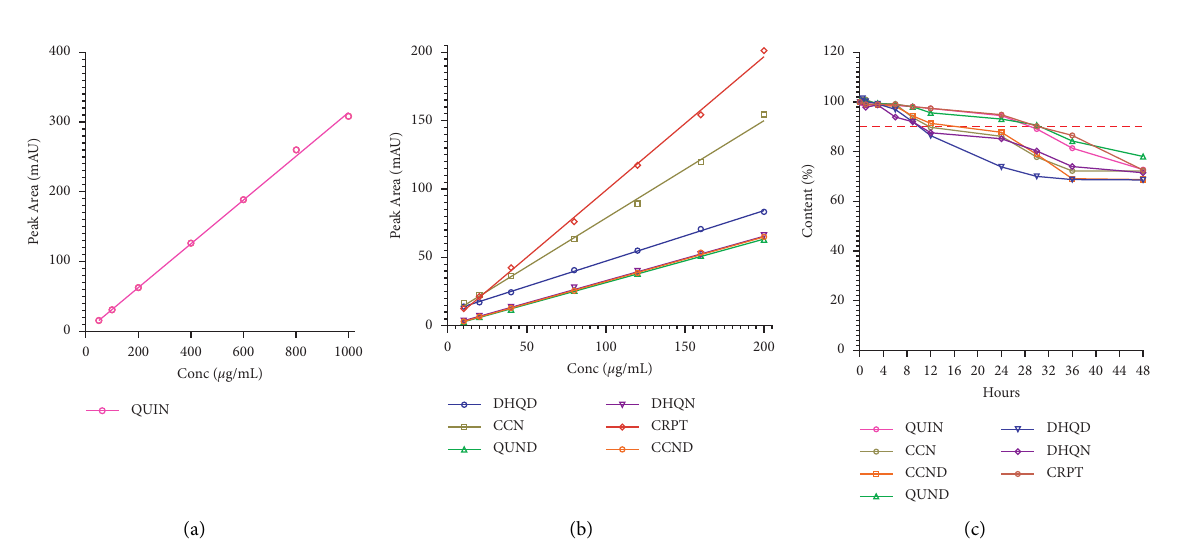
Figure 2: Results for linearity and stability studies in the method validation. (a) Linearity responses for quinine over the concentration range 50–1000 μ g/mL. (b) Linearity responses for all other analytes each at concentration range 10–200 μ g/mL. (c) Stability of analyte solution studies. The red horizontal line indicates the lowest permissible content of analytes (90% of starting concentrations). The stability of the analyte solutions ranged between 6 and 12 hours after sample preparation.